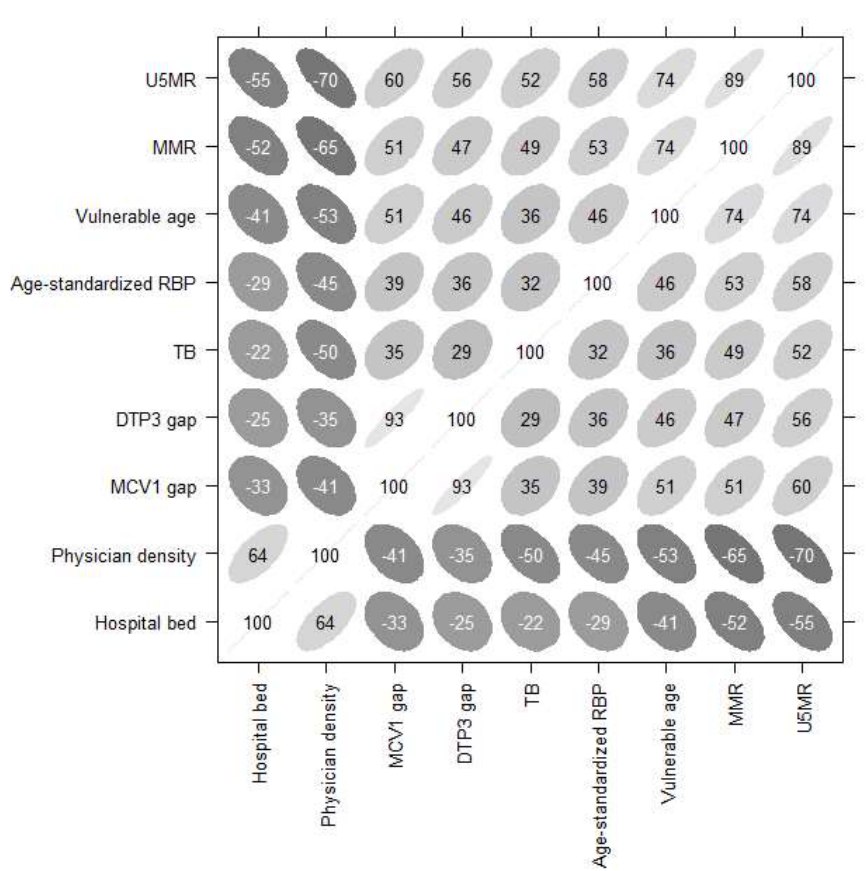
Figure 1. Correlation matrix of the proposed nine health indicators. Note: The figure depicts each correlation by an ellipse whose shape tends toward a line with a slope of one (or − 1) for correlation coefficients near one (or − 1), and toward a circle for a correlation coefficient near zero. In addition, 100 times the correlation coefficient is printed inside the ellipse (significance level at α = 0.05).